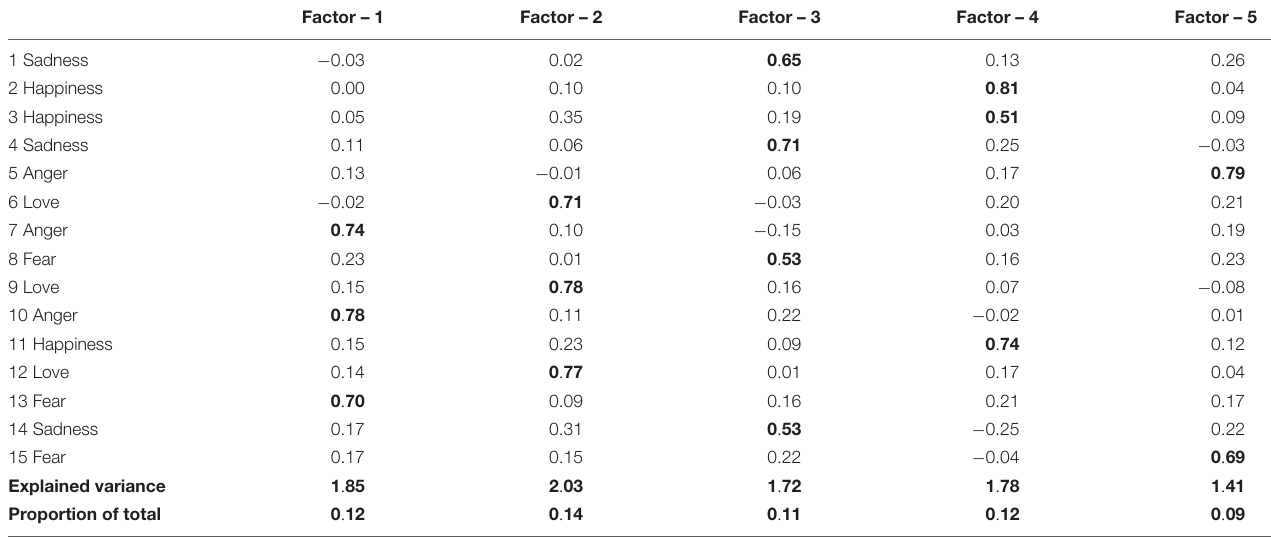
TABLE 2 | Factor loadings of the ECS